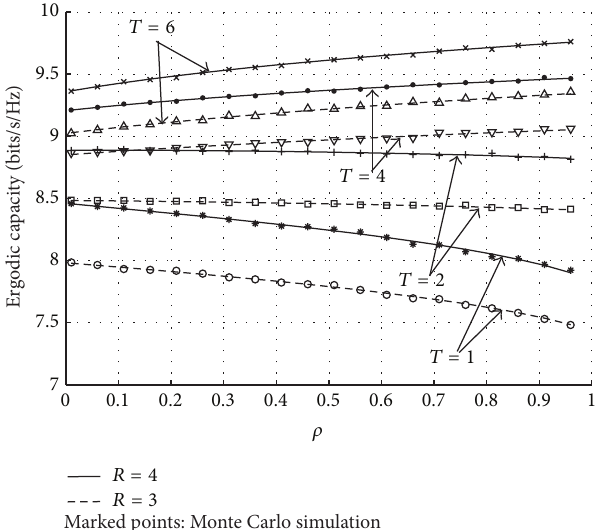
Figure 6: Ergodic capacity versus constant correlation parameter 𝜌 for 𝑅 = 3, 4 ; 𝑇 = 1, 2, 4,6 . Average SNR per branch is 20 dB.